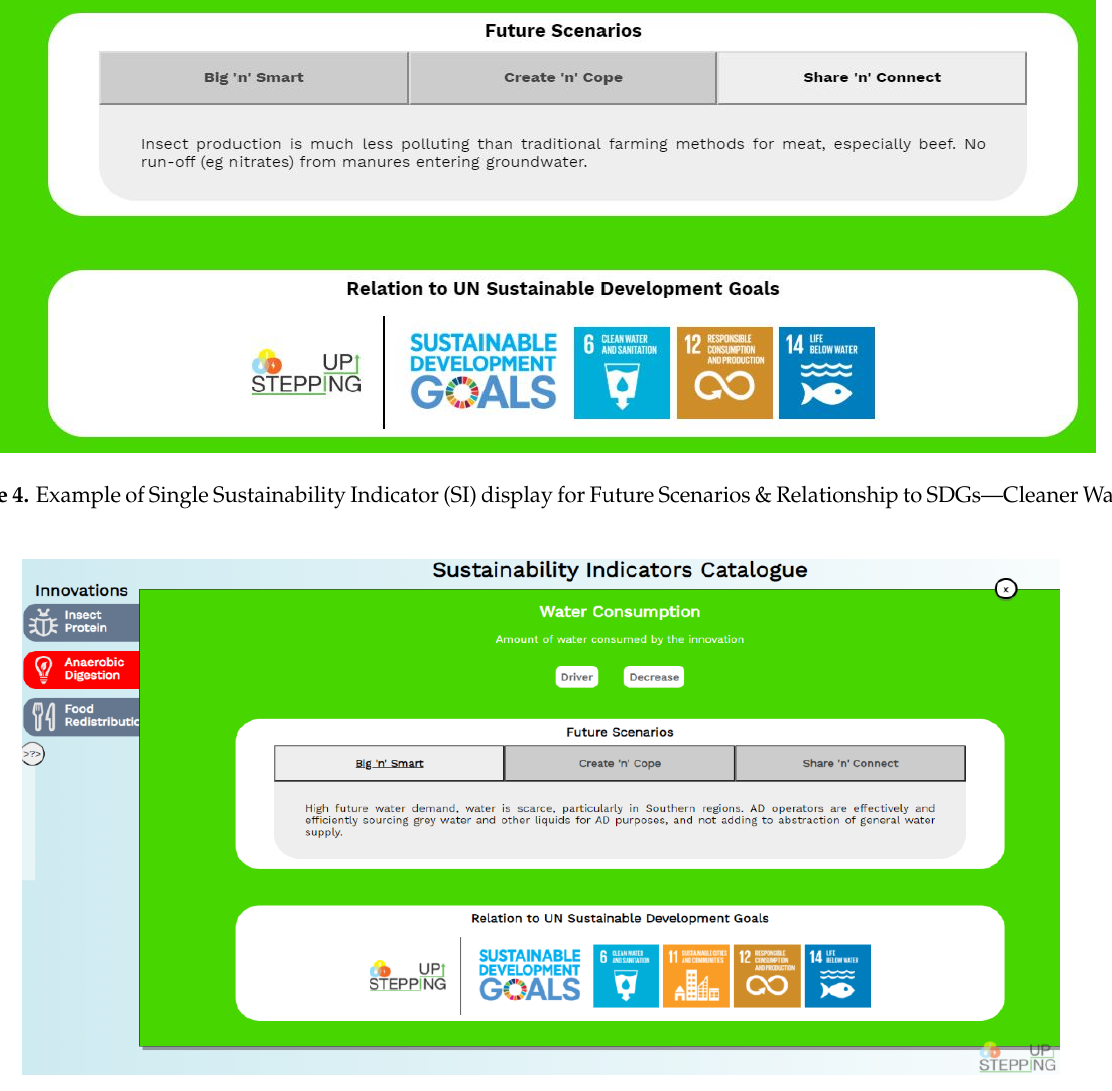
Figure 5. Example of Single Sustainability Indicator (SI) display for Future Scenarios & Relationship to SDGs—Water Consumption.